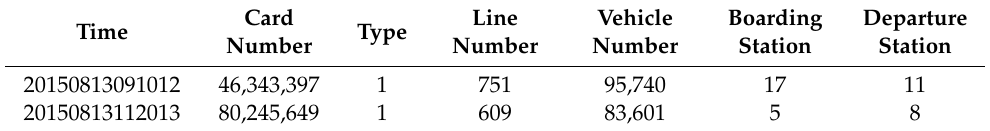
Table 2. Sample records of smart card